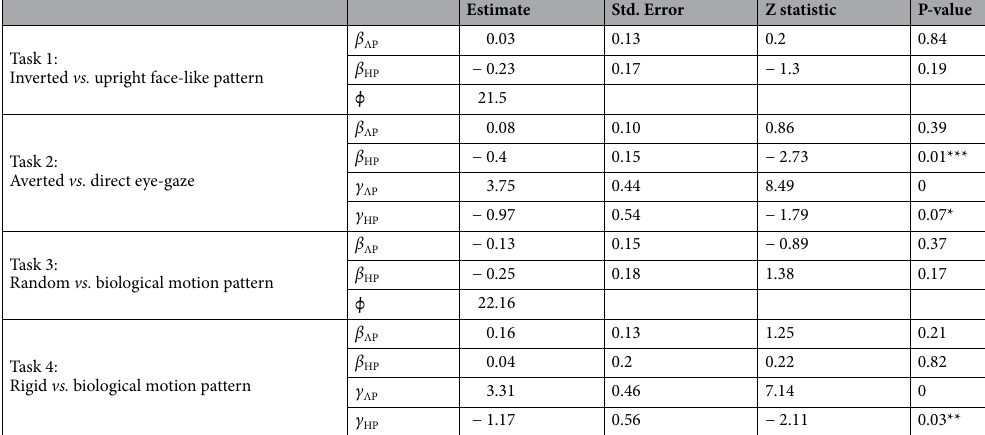
Table 2. Estimates and standard errors, z -statistic and its p -value for the variable dispersion beta linear models. Note that β ’s denote that parameters for the mean components, γ’s denote the parameters for the dispersion components of the model, is the parameter for the overall dispersion parameter. Since the Group variable (HR vs. LR) is dichotomic, β LR is the intercept of the model, therefore it is the baseline. *** p ≤ 0.01, ϕ ** p ≤ 0.05, * p ≤ 0.1.